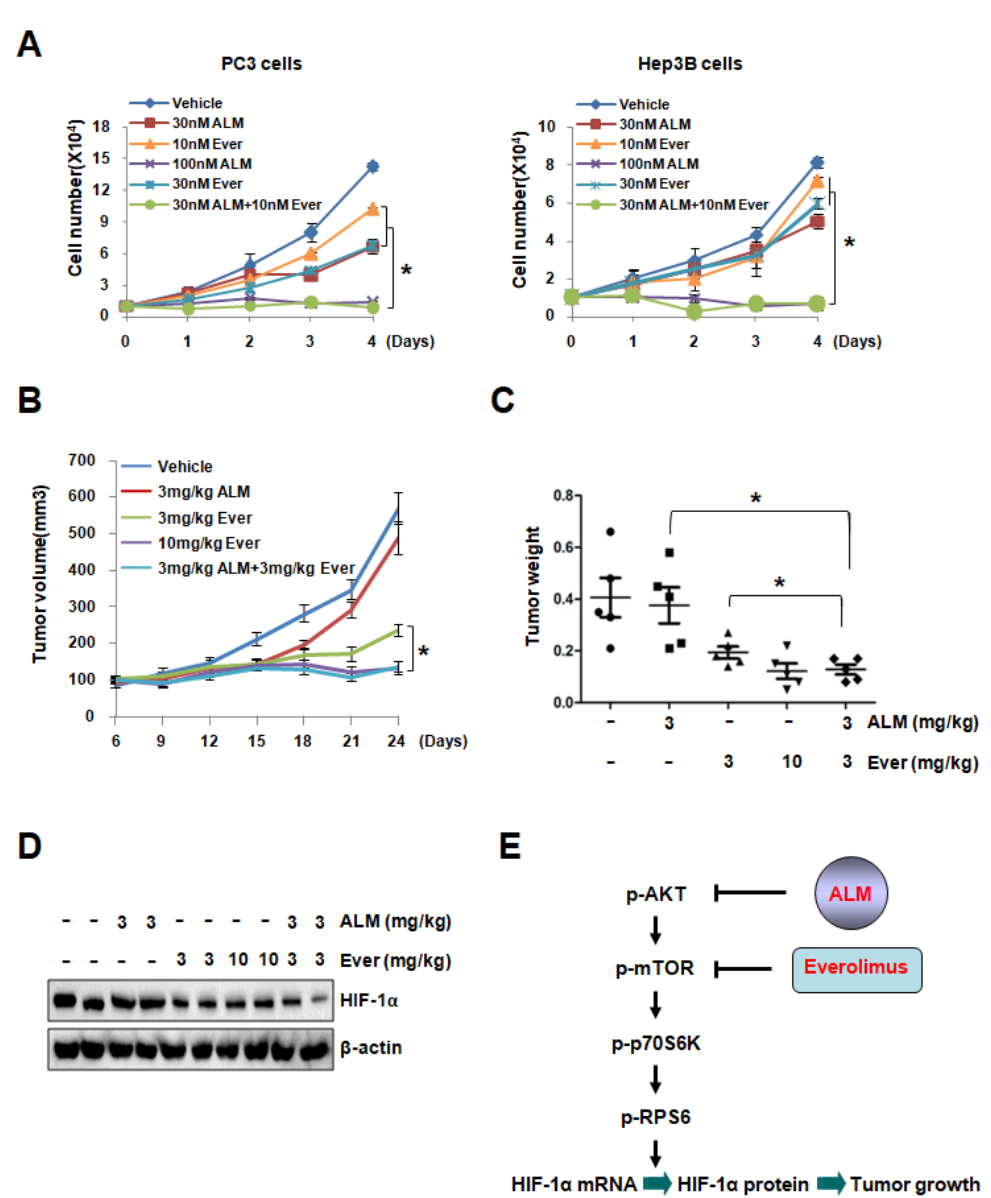
Figure 5. Low dose of ALM enhances the inhibitory e ff ect of mTOR inhibitors on cell growth. ( A ) Cell growth curves of PC3 and Hep3B cells treated with indicated dose of vehicle, ALM, Everolimus, or combination of ALM with Everolimus. ( B ) BALB / C Nude male mice were implanted with PC3 cells subcutaneously on the flank. Mice received daily i.p injection of indicated dosage of Vehicle, ALM, Everolimus or combination of ALM with Everolimus. Tumor volume was determined from day 6 to day 24 (mean ± s.e.m., P < 0.0001 by Student’s t -test). ( C , D ) Tumors were collected and weighted after sacrificing mice ( C ), followed by Western blot to detect HIF-1 α protein level in representative tumor samples of each group ( D ). ( E ) Working model shows that ALM, produced by Streptomyces flavoretus , inhibits HIF-1 α protein synthesis by down-regulating mTOR signaling cascade. Furthermore, ALM enhances the anti-tumor e ff ect of mTOR inhibitor Everolimus, suggesting its therapeutic potential in the combination therapy for cancer patients, In addition, * P < 0.05 compared between the indicated groups, while • indicated Vehicle group, (cid:4) indicated 3 mg / kg ALM group, (cid:78) indicated 3 mg / kg Ever group, (cid:72) indicated 10 mg / kg Ever group, and (cid:7) indicated 3 mg / kg ALM + 3 mg / kg Ever